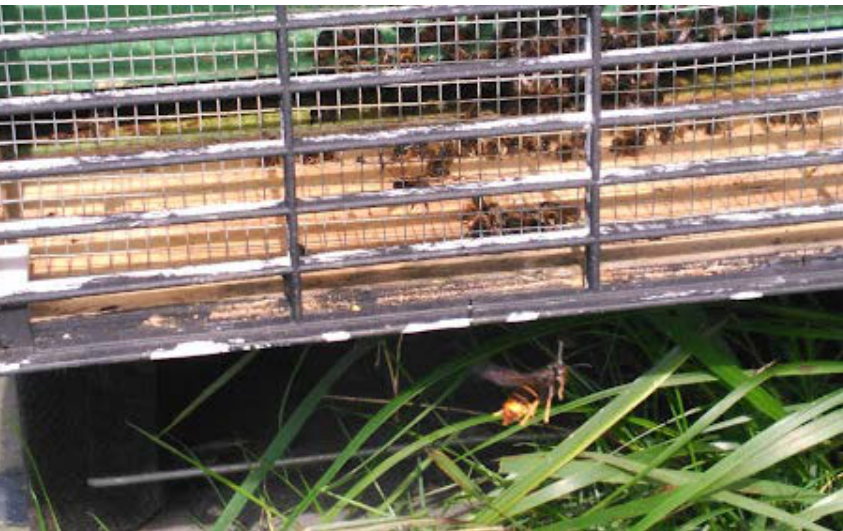
Figure 1. A female Vespa velutina specimen in static flight in front of the beehive’s entry at the apiary, located in San Pedro de Viveiro at the province of Lugo (Galicia, Spain).